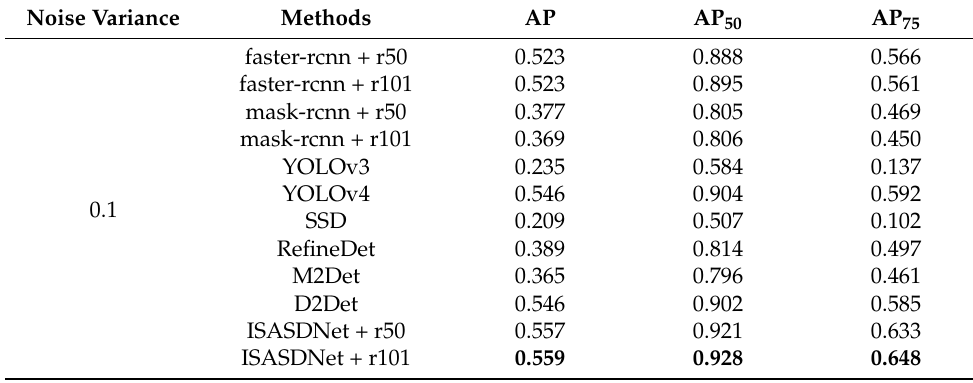
Table 9. AP under different